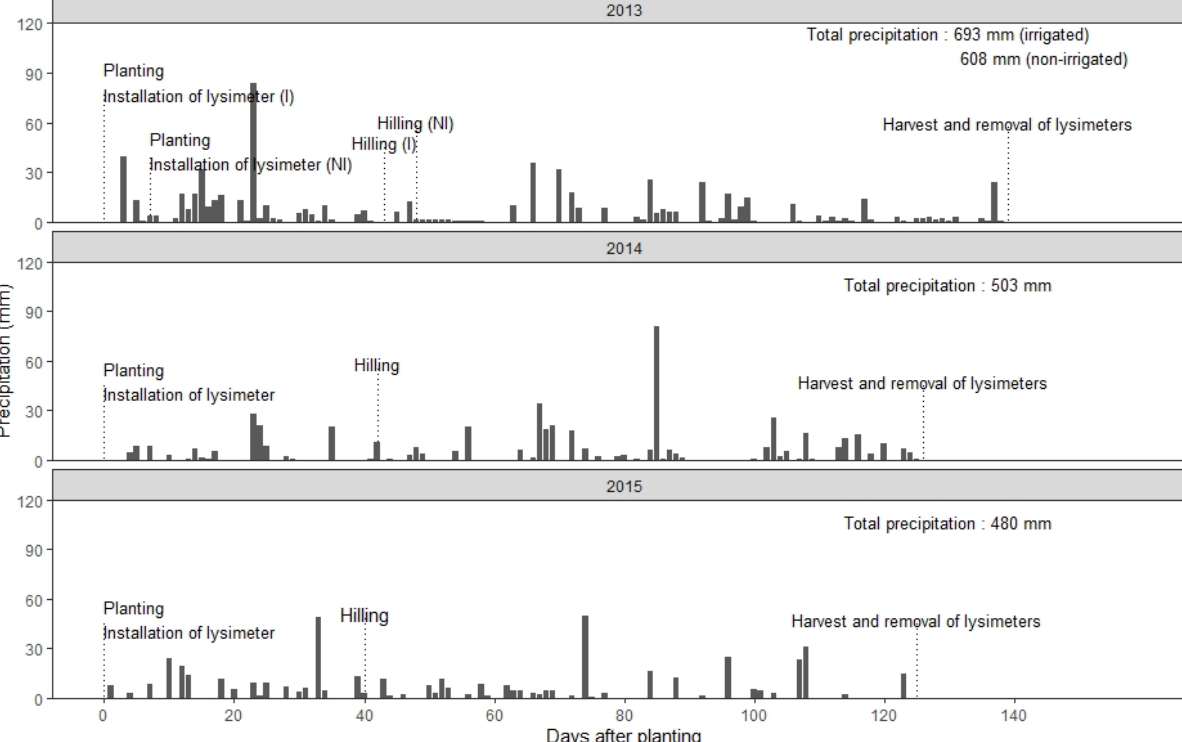
Figure 2. Daily precipitation and main field operations in 2013, 2014, and 2015 at irrigated (I) and non-irrigated (NI) sites.